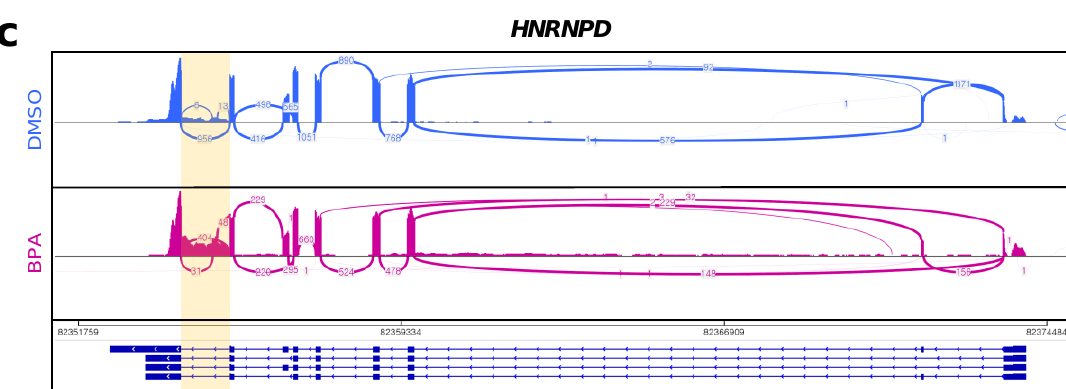
Figure 4. Transcriptome dynamics identifies the alternative splicing events in BPA-treated Y79 cells. ( a ) Alternative splicing events were analyzed by the MATS and identifies alternative splicing events. Types of alternative splicing events detected and counted their frequencies in group-wise comparisons. Protein coding genes obtained from alternative splicing events indicated as the percentage of genes. Differential splicing events in the BPA-treated group shown the clear retained intron (RI) in Mago Homolog B, Exon Junction Complex Subunit ( MAGOHB ) ( b ) and Heterogeneous Nuclear Ribonucleoprotein D ( HNRNPD ) ( c ) genes. The yellow shadow indicates the retained intron region in BPA-treated Y79 cells .